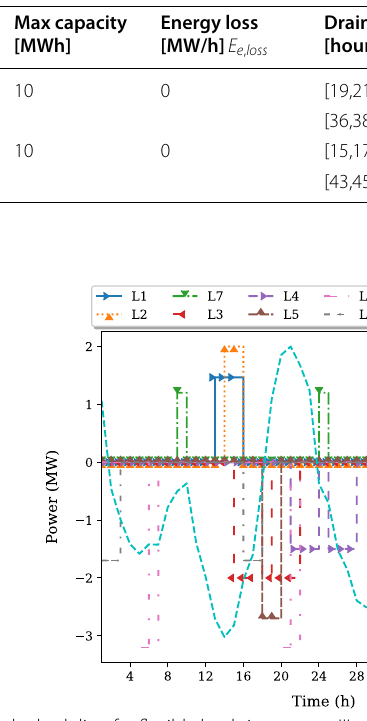
Table 8 Characteristics of storages in use case III